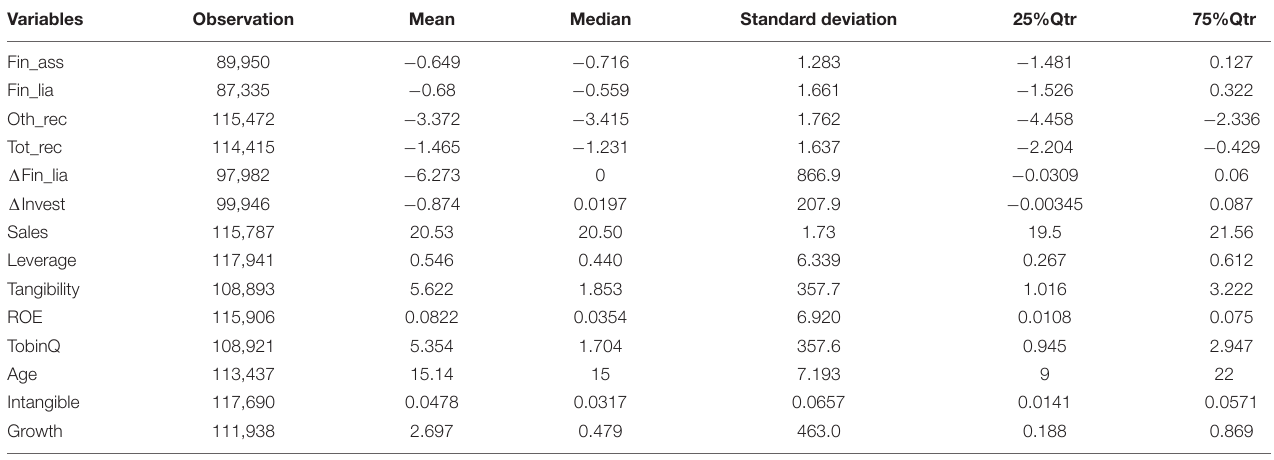
TABLE 1 | Descriptive statistics of main variables.